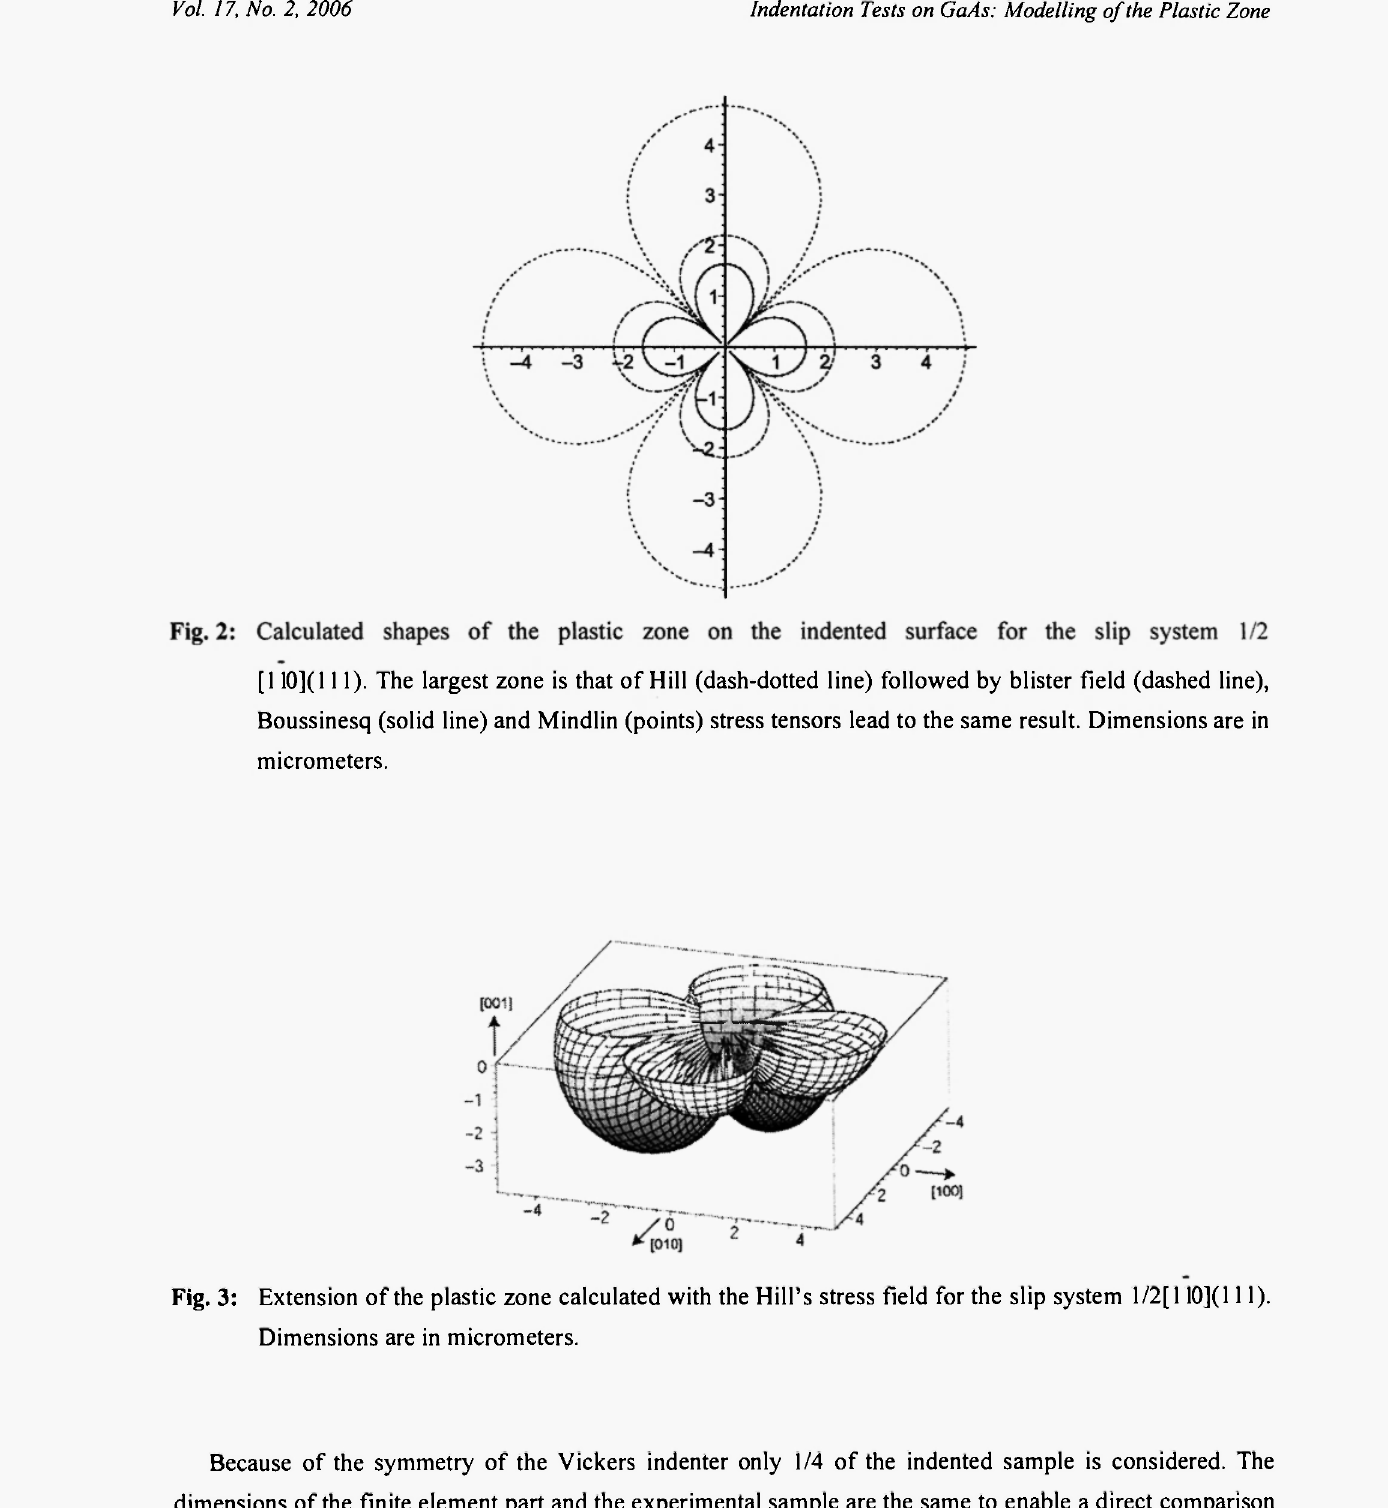
Fig. 3: Extension of the plastic zone calculated with the Hill's stress field for the slip system 1/2[110](111). Dimensions are in